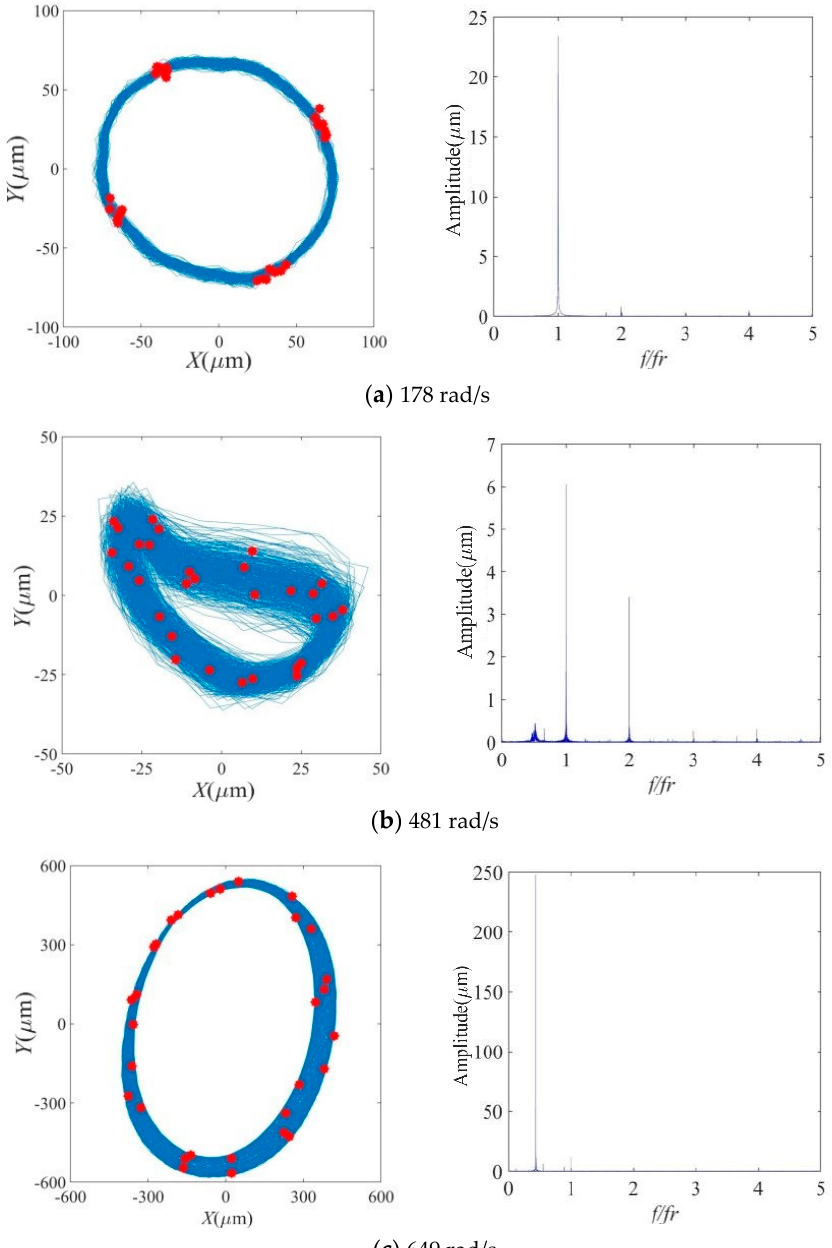
Figure 20. Trajectory of shaft center with the Poincaré map ( left side ) and the power spectrum ( right side ) for the rotating disk at different rotating speeds and oil pressure of 1.2 MPa.